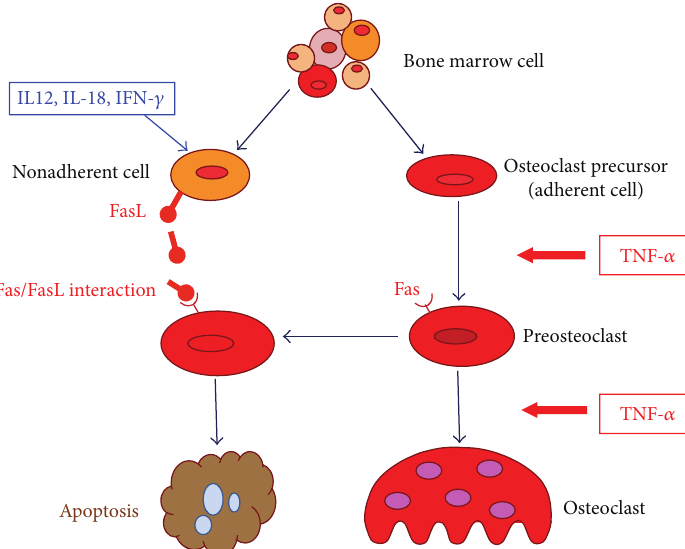
Figure 2: The mechanism of IL-12-, IL-18-, and IFN- 𝛾 -induced apoptosis in bone marrow cell culture. TNF- 𝛼 induced the expression of Fas on preosteoclast, and IL-12 and IL-18 induce the expression of FasL on nonadherent cells. The Fas/FasL interaction induced the apoptosis of preosteoclast in bone marrow cell